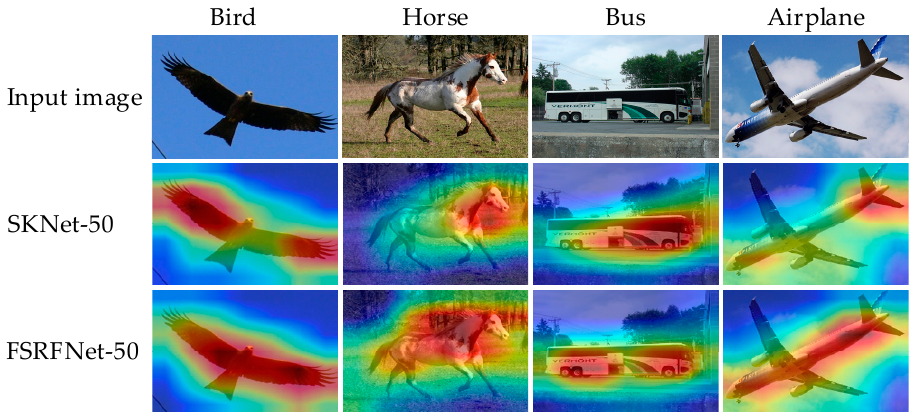
Figure 8. The Grad-CAM visualization results, using SKNet-50 and our proposed FSRFNet-50 as backbone networks.